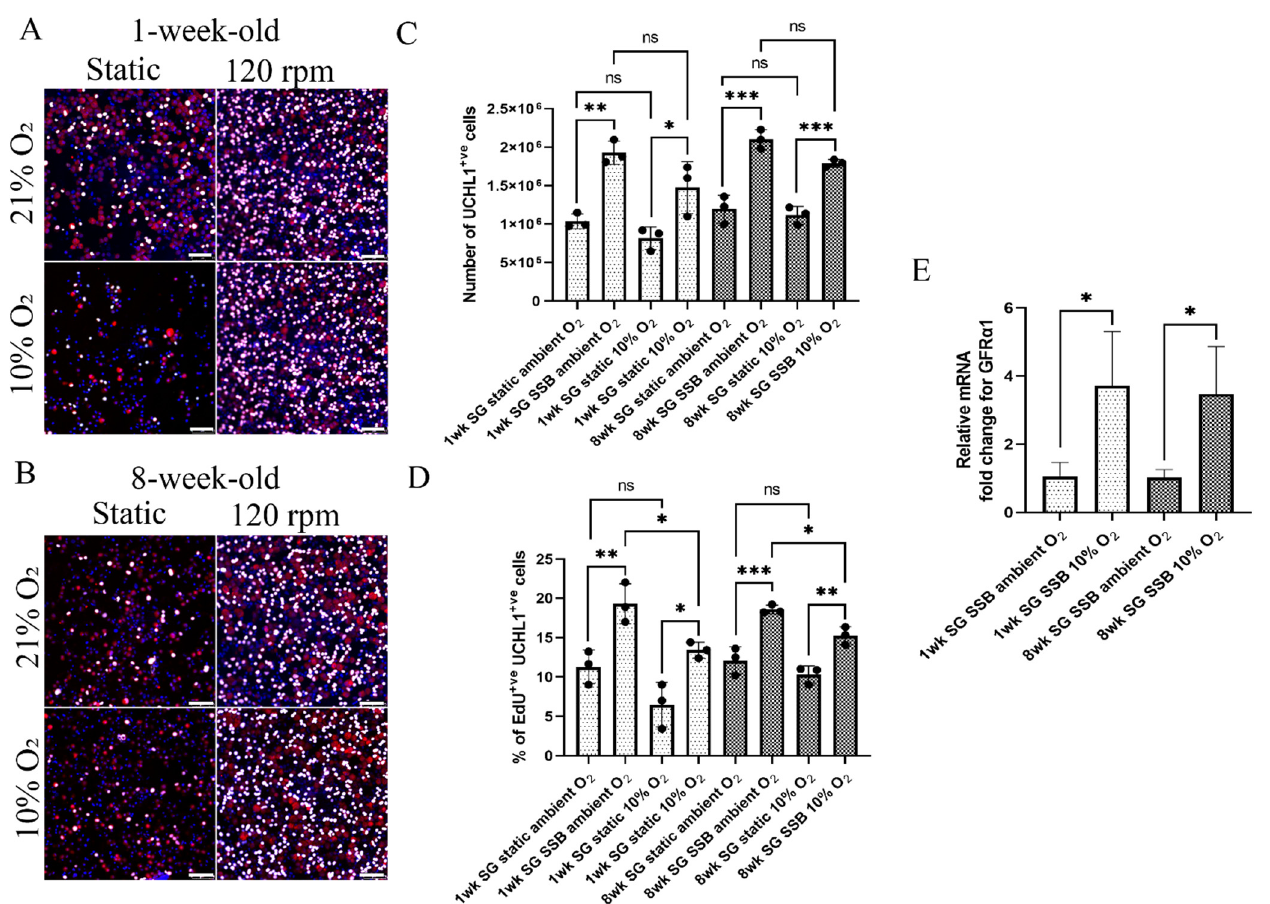
Figure 2. Spermatogonia cultured at 10% O 2 tension proliferate less than those cultured at ambient O 2 tension but contain more undifferentiated cells: ( A , B ) immunofluorescence images of 1-week-old and 8-week-old spermatogonia after 14 days of culture: red, UCHL1; grey, EdU; blue, DAPI. Scale bars 75 µm; ( C ) number of 1-week-old and 8-week-old spermatogonia (SG) harvested after 14 days of culture; ( D ) percentage of proliferating 1-week-old and 8-week-old spermatogonia (SG) after 14 days of culture; ( E ) relative mRNA fold change of GFR α 1 for 1-week-old and 8-week-old spermatogonia (SG). n = 3, mean ± SD. p > 0.05 (ns), p ≤ 0.05 (*), p ≤ 0.01 (**), p ≤ 0.001 (***).